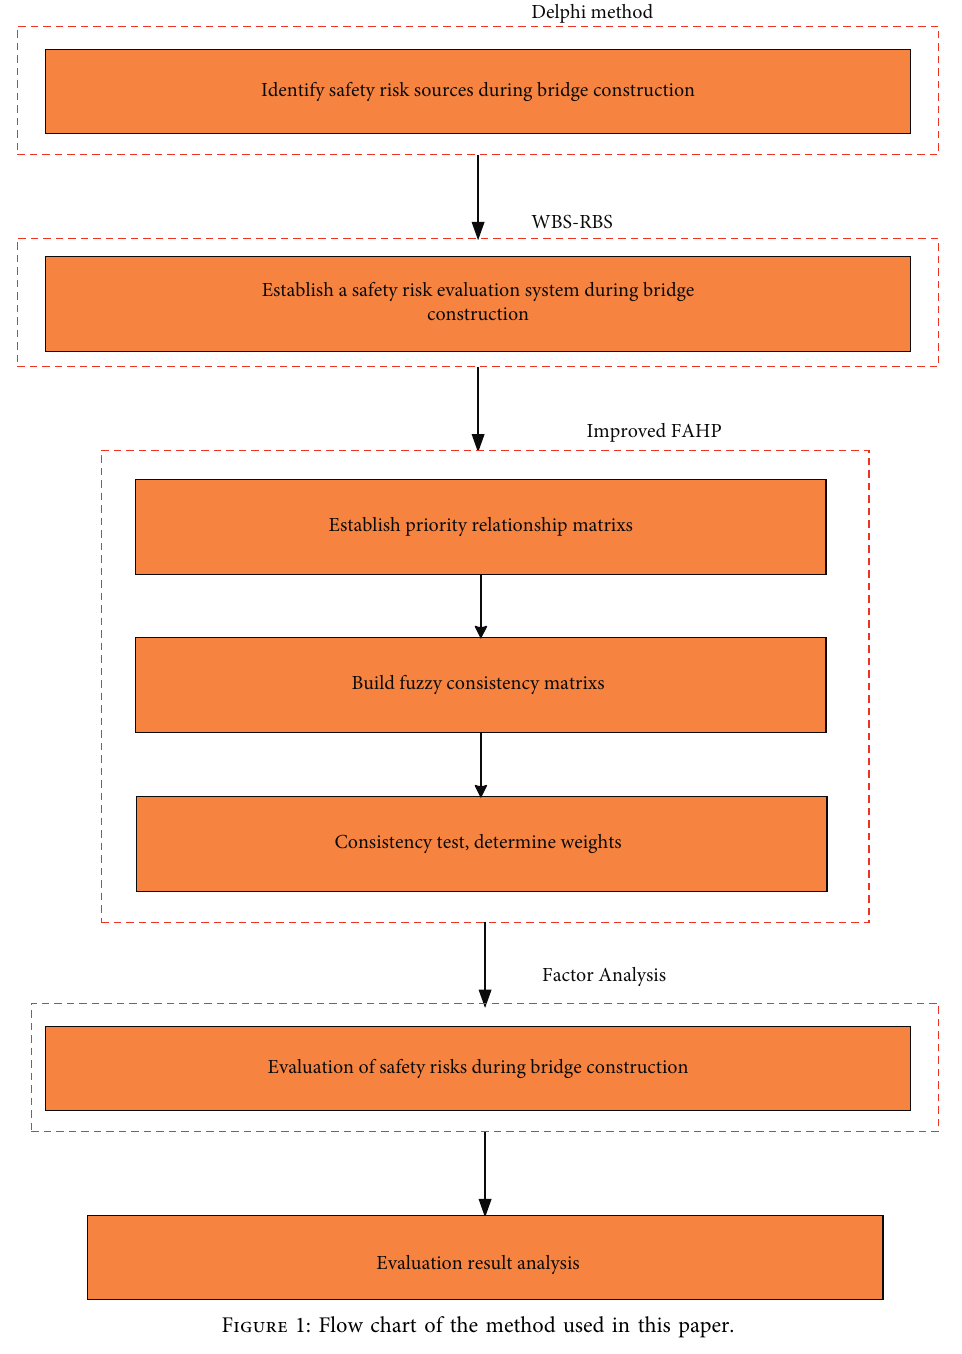
Figure 1: Flow chart of the method used in this